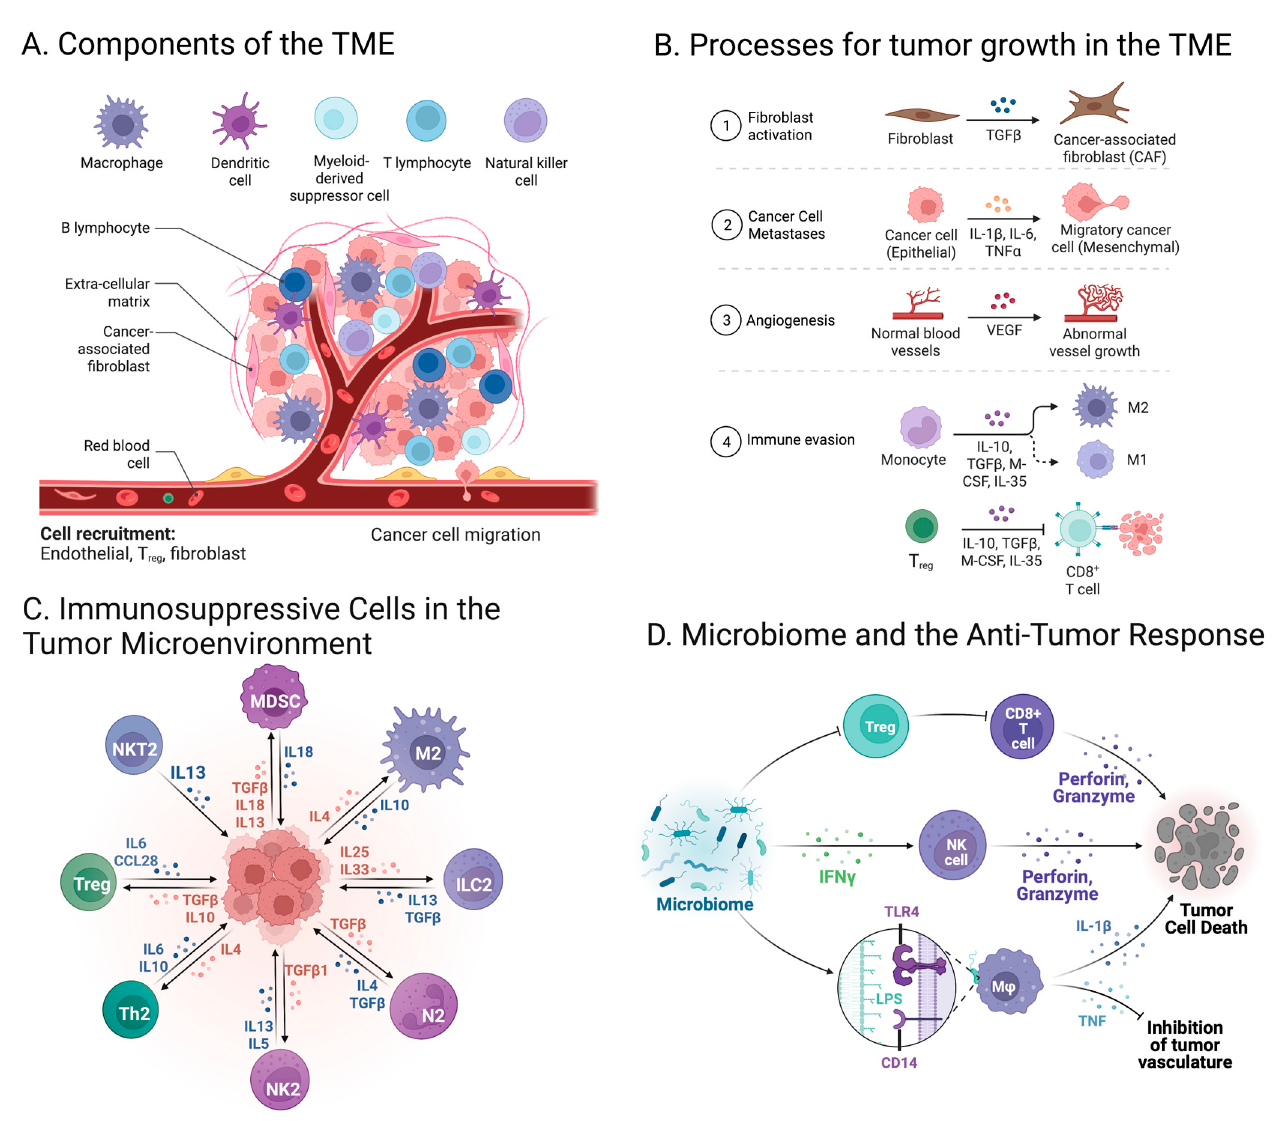
Figure 1. Tumor microenvironment. ( A ) The TME develops around tumor cells and is composed of the extracellular matrix, immune cells, mesenchymal stromal cells, blood vessels, and cancer-associated fibroblasts. ( B ) The tumor is able to grow and metastasize due to fibroblast activation, cytokine signaling, angiogenesis, and immune evasion. ( C ) Important immune cells in the TME include T cells, B cells, natural killer cells, and macrophages. ( D ) Research has shown that the gut microbiome has an integral role in the anti-tumor immune response and subsequently impacts a patient’s response to ICIs (Created with BioRender.com; (accessed on 15 January 2023)).